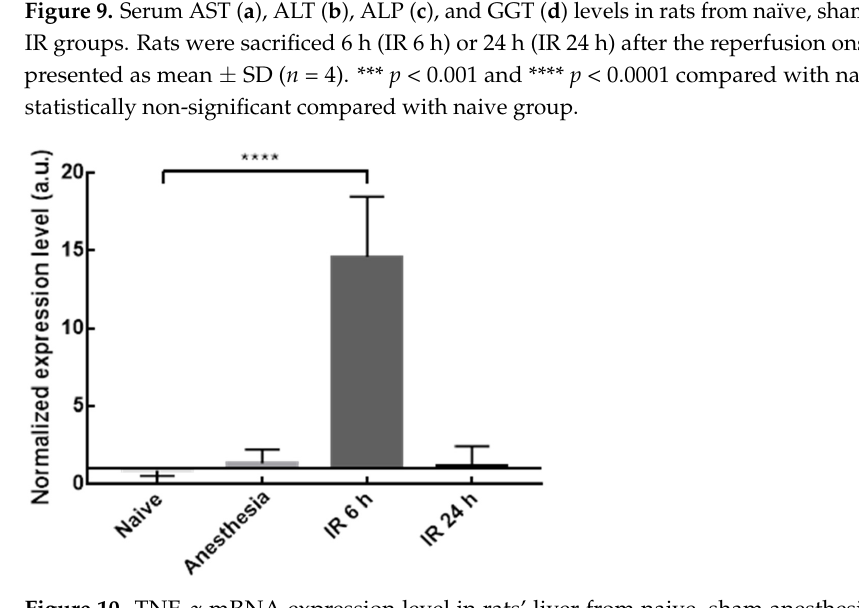
Figure 10. TNF- α mRNA expression level in rats’ liver from naive, sham anesthesia, or IR group. Rats were sacrificed 6 h (IR 6 h) or 24 h (IR 24 h) after the reperfusion onset. Results are presented as mean ± SD ( n = 4). **** p < 0.0001 compared with naive group.